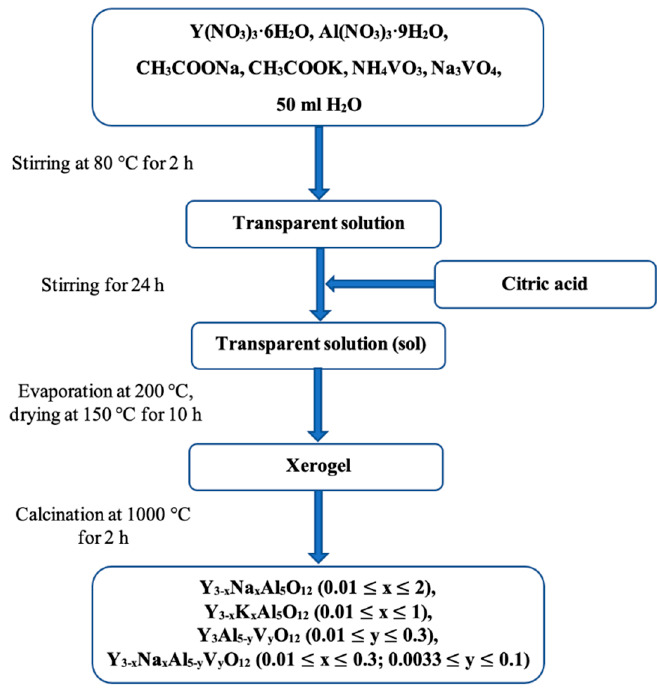
Figure 7. Scheme of sol-gel synthesis of garnets with different stoichiometry.